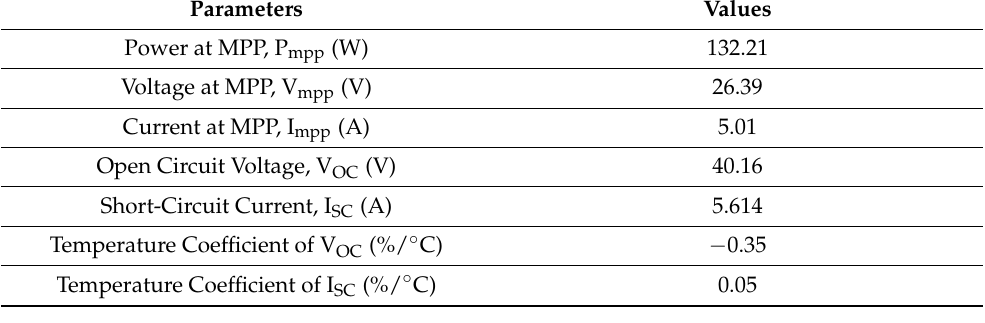
Table 3. PV panel characteristics at STC.